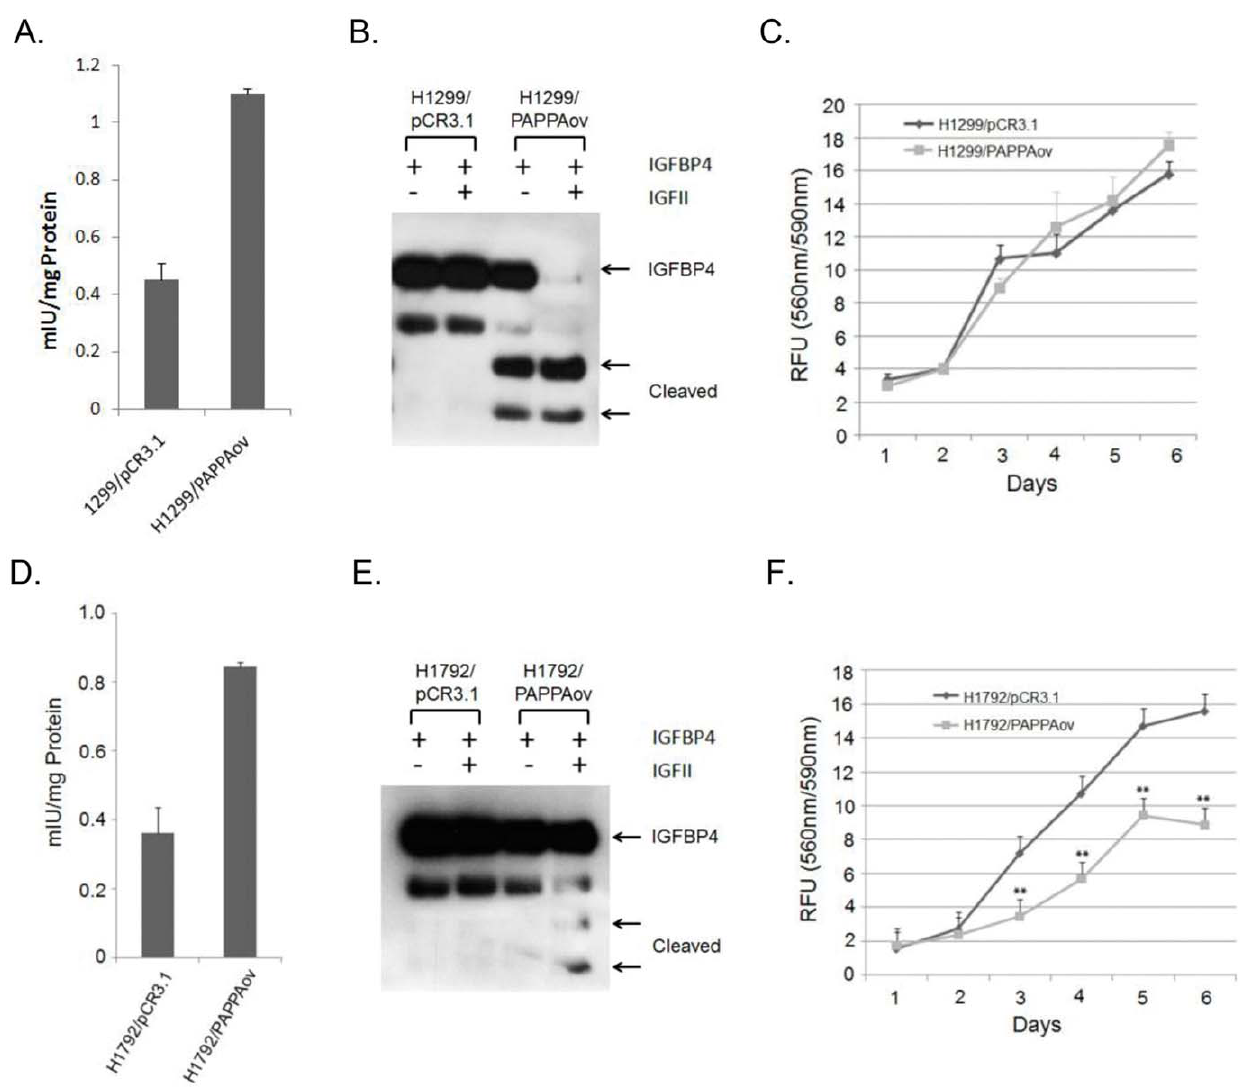
Figure 4. Role of PAPPA on growth of lung cancer cells invitro . (A) Protein levels of PAPPA in H1299 cells over-expressing PAPPA. PAPPA levels in protein extracts from H1299 cell lines stably transfected with PAPPA expression vector (H1299/PAPPAov) and empty control vector (H1299/ pCR3.1) were determined by ELISA kit as described in Materials and Methods. Results shown are Mean 6 SE of triplicate determinations. (B) IGF dependent protease activity in conditioned medium from H1299/pCR3.1 and H1299/PAPPAov. (C) Growth curve of H1299/pCR3.1 and H1299/ PAPPAov cell lines. Viable cells at different time points were measured by CellTiter-Blue as described in Materials and Methods. Results were expressed as Mean 6 SE of triplicate determinations of Relative Fluorescence Unit (RFU) of three independent experiments. (D) Protein levels of PAPPA in H1792 cells over-expressing PAPPA. PAPPA levels in protein extracts from H1792 cell lines stably transfected with PAPPA expression vector (H1792/PAPPAov) and empty control vector (H1792/pCR3.1) were determined by ELISA kit as described in Materials and Methods. Results shown are Mean 6 SE of triplicate determinations. (E) IGF dependent protease activity in conditioned medium from H1792/pCR3.1 and H1792/PAPPAov. (F) Growth curve of H1792/pCR3.1 and H1792/PAPPAov cell